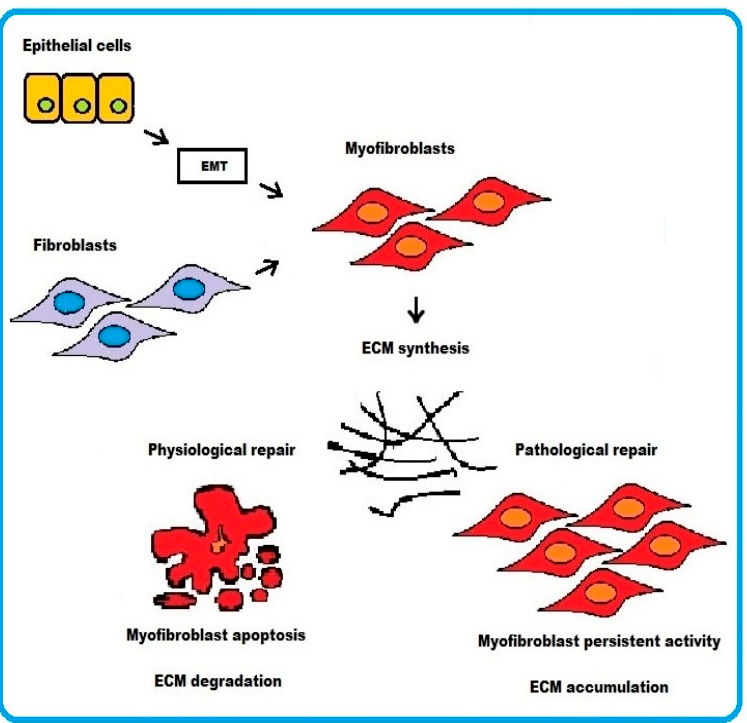
Figure 1. Schematic representation of the cellular mechanisms underlying fibrosis. Two pathways are depicted: (i) epithelial cells transforming into myofibroblasts via EMT or (ii) activated fibroblasts differentiating into myofibroblasts. In physiological wound healing, myofibroblasts disappear by apoptosis. Conversely, the persistence of myofibroblasts activity in pathological wound healing process results in excessive accumulation of ECM.